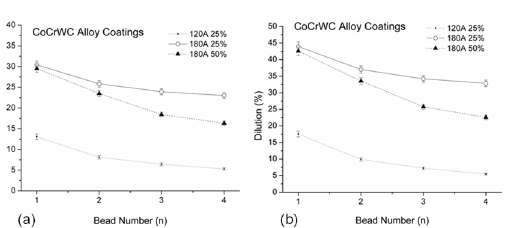
Figure 5. Measured Iron Content (a) and Dilution bead by bead (b).